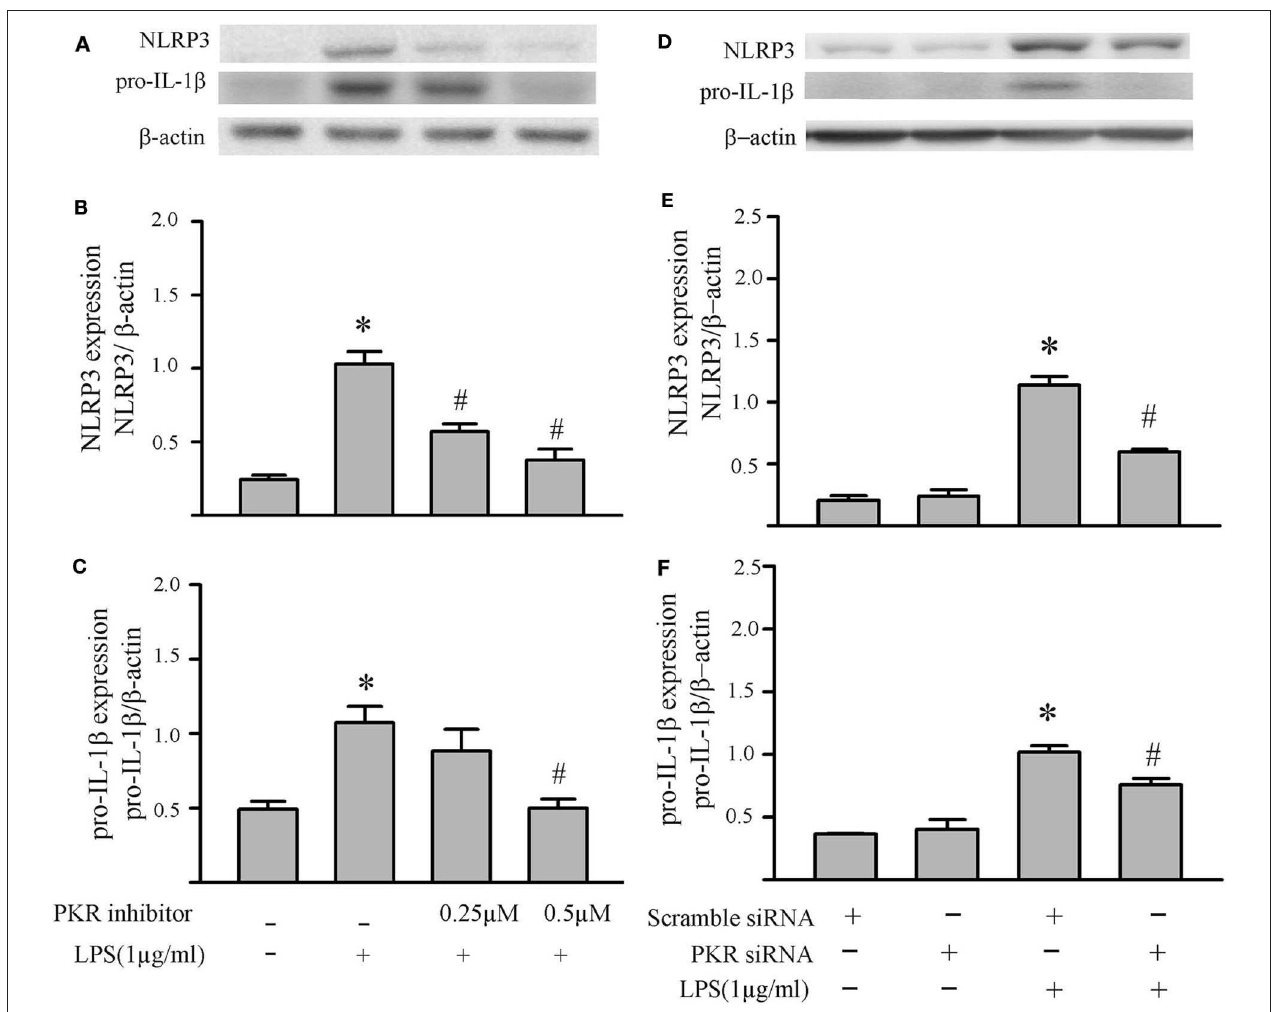
FIGURE 4 | Inhibition of PKR activity or down-regulation of PKR protein decreases LPS-induced priming of the NLRP3 inflammasome. (A–C) Fibroblasts were pretreated with the PKR inhibitor for 30min and subsequently challenged with LPS (1 µ g) for 6h. Representative Western blots are shown in (A) and densitometric analyses in (B,C) . (D–F) Forty-eight hours after transfection with PKR siRNA or scrambled siRNA, the fibroblasts were challenged by LPS (1 µ g) for 6h. Representative Western blots are shown in (D) and densitometric analyses in (E,F) . n = 3, * p < 0.05 as compared with control; # p < 0.05 as compared with